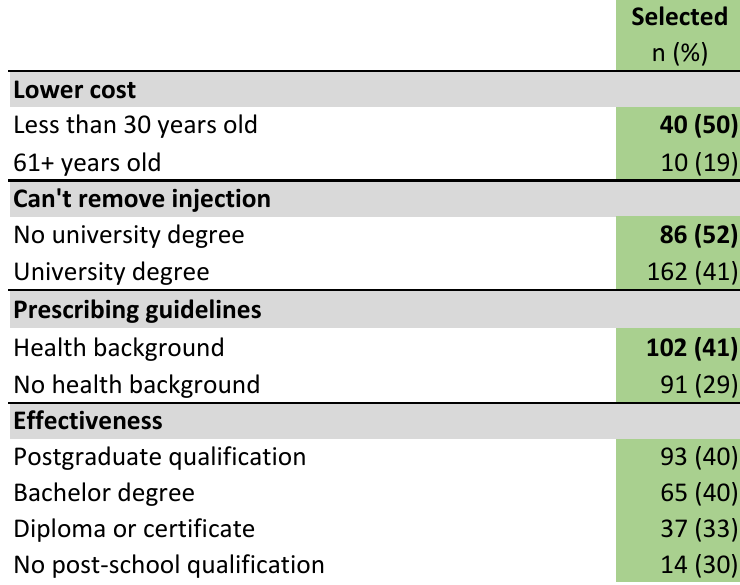
Figure 12. Differences by respondent demographic category in popularity of reasons to give a course of antibiotic tablets instead of a long-acting antibiotic injection. Bold type indicates a significantly higher subgroup result ( p <